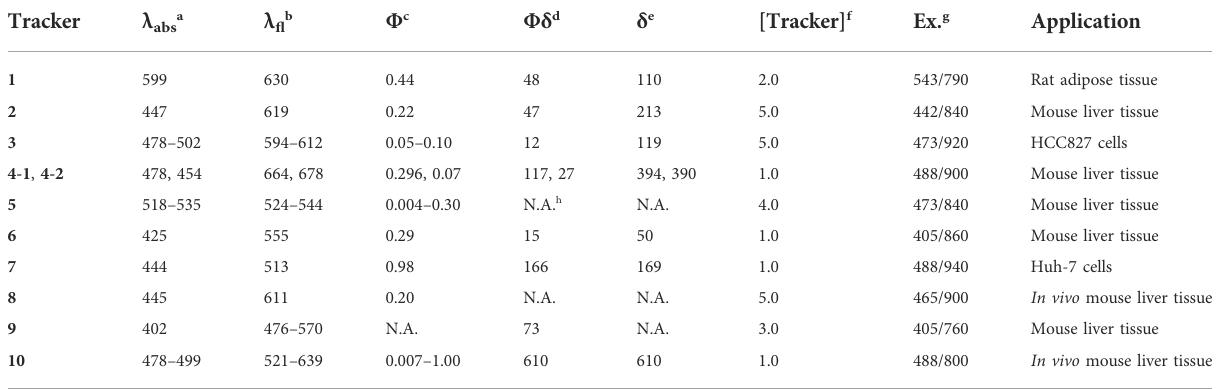
TABLE 1 Photophysical data of the representative small-molecule TP LDs trackers.